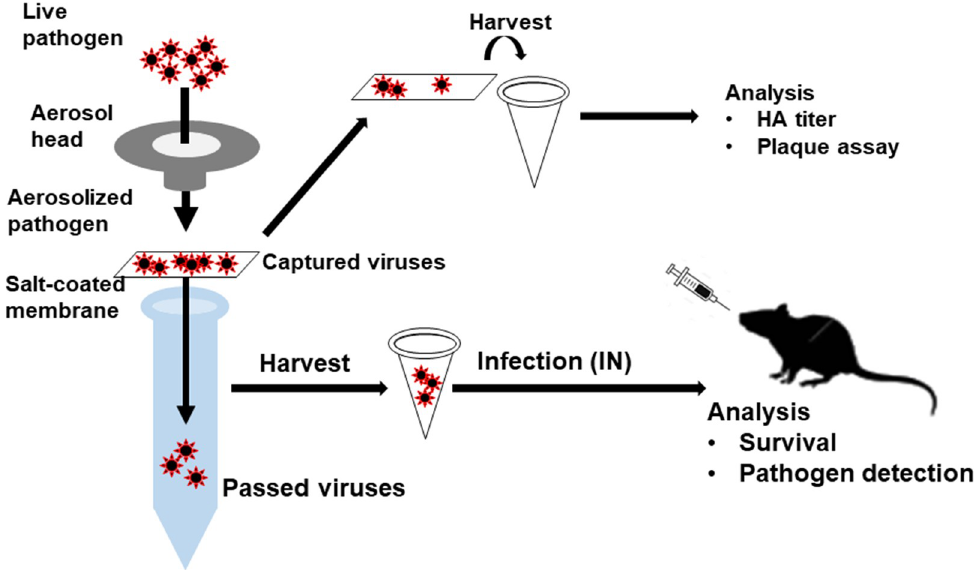
Fig 1. Experimental design. Live influenza viruses (A/H3N2, A/H5N1) were aerosolized by aerosol generator nebulizer set. Virus aerosols were exposed to the surgical mask filters, and the viruses either captured or passing through filters were harvested. Both captured and passed viruses were analyzed for virus hemagglutinin activity, infectivity, and pathogenicity in